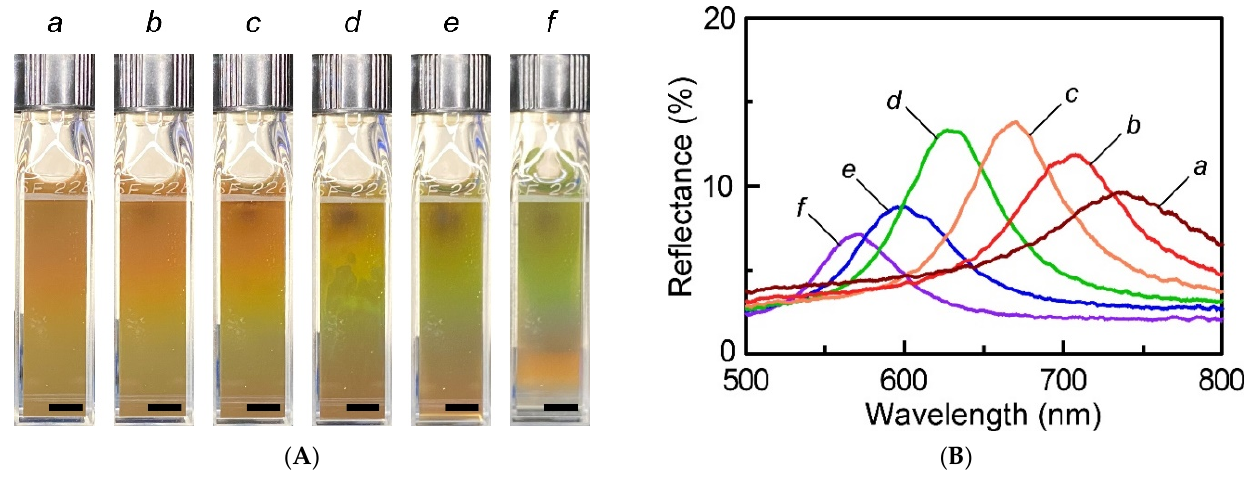
Figure 4. Changes in snapshot image ( A ) and reflection spectrum ( B ) of a suspension of M-3 as a function of the external magnetic field of 28 mT (a), 36 mT (b), 48 mT (c), 65 mT (d), 90.4 mT (e), and 220 mT (f). All black scale bars in the images represent 0.5 cm.